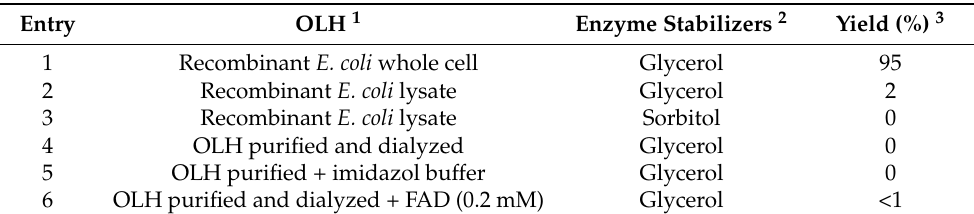
Table 1. Hydration of oleic acid using different forms of recombinant OLH from L. rhamnosus as